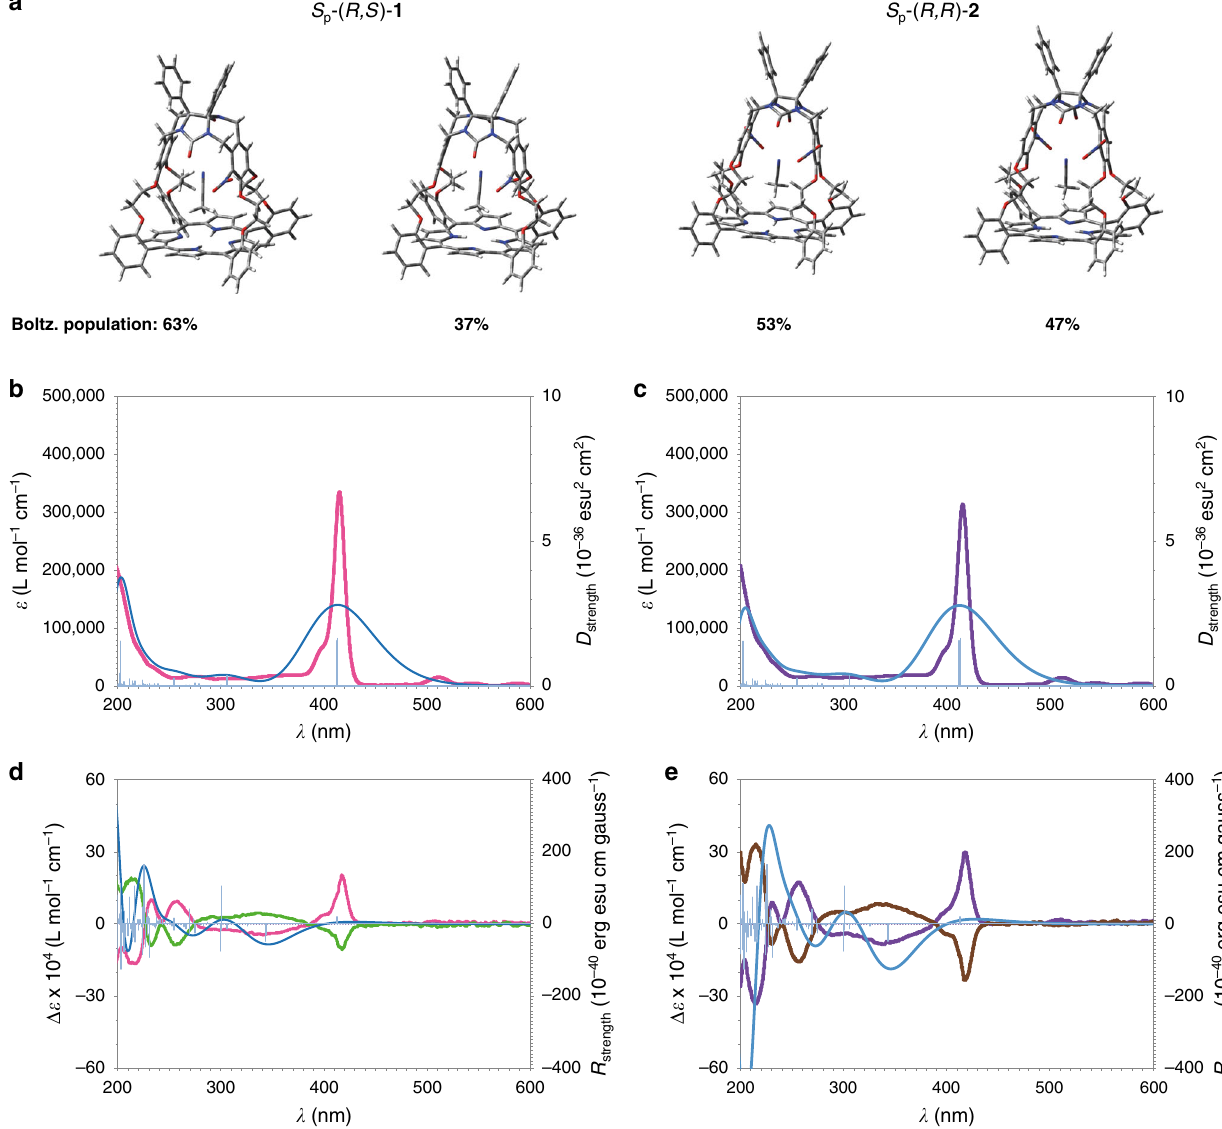
Fig. 4 UV and ECD spectra of chiral porphyrin-cage compounds. a Calculated conformations and Boltzmann population of S p -( R , S )- 1 and S p -( R , R )- 2 . b UV-Vis spectra measured for ( + ) − 1 (magenta line) and calculated for S p -( R , S )- 1 (blue line and blue bars: dipole strengths). c UV-Vis spectra measured for ( + ) − 2 (purple line) and calculated for S p -( R , R )- 2 (blue line and blue bars: dipole strengths). d ECD spectra measured for ( + ) − 1 (magenta line), ( − ) − 1 (green line), and calculated for S p -( R , S ) -1 (blue line and blue bars: rotational strengths). e ECD spectra measured for ( + ) − 2 (purple line), ( − ) − 2 (brown line), and calculated for S p -( R , R )- 2 (blue line and blue bars: rotational strengths). Solvent CH 3 CN, c = 5.55 × 10 − 5